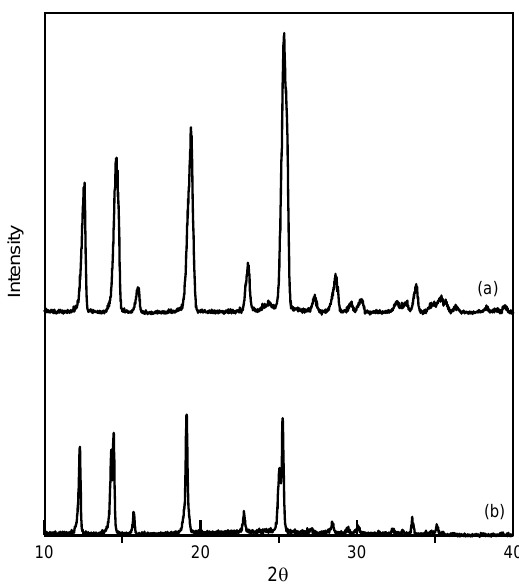
Figure 5. Comparison of FTIR spectra of ( a ) unprocessed ethenzamide and ( b ) RESS-processed ethenzamide from Experiment 12.